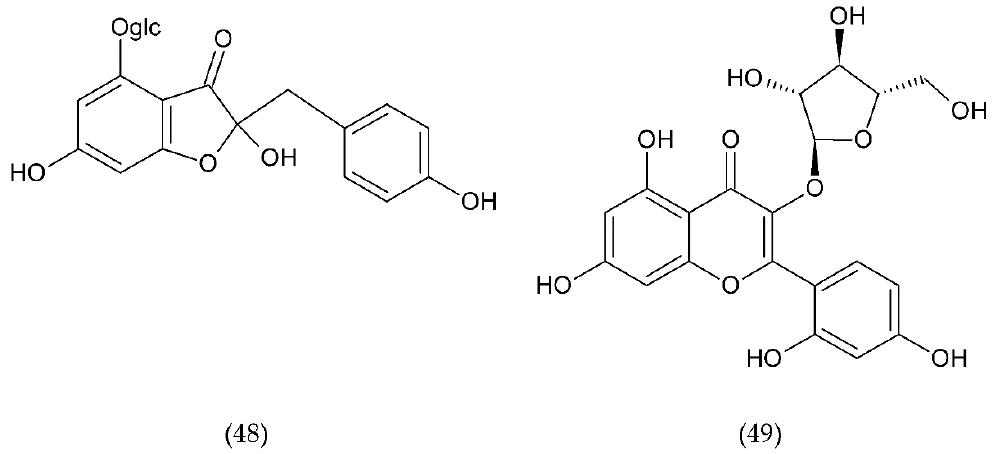
Figure 16. Chemical structure of hovertrichozide (48) and avicularin (49).